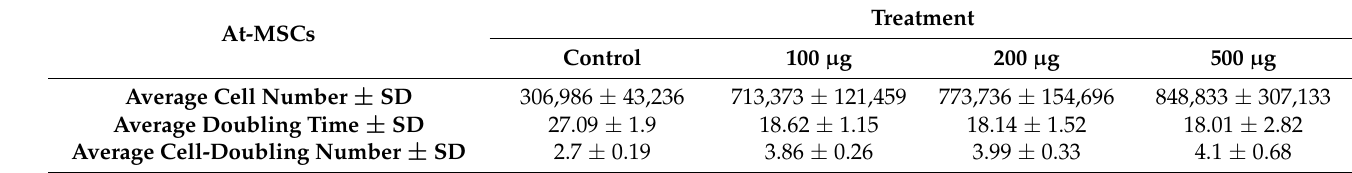
Table 2. Average cell number, cell-doubling time, and cell-doubling number of At-MSCs treated with different LLP amounts (100 to 500 µ g). Treatments significantly increased the average cell number and cell-doubling number ( p < 0.001) compared to control cultures, while cell-doubling time was significantly lower for treated cells ( p < 0.001). No differences were observed between different